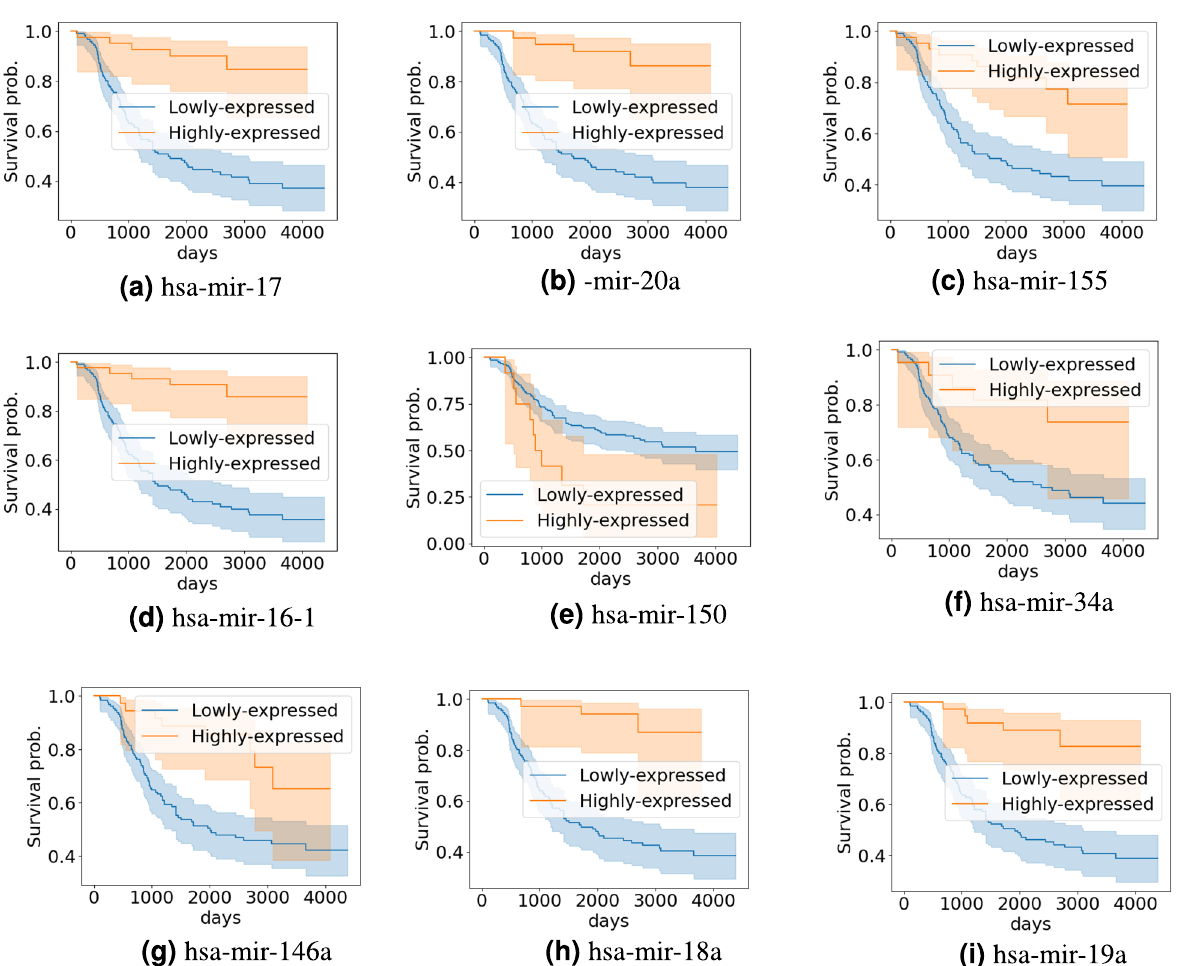
Figure 2. Kaplan–Meyer survival curves of PBLL patients stratified by the top miRNAs with the top highest prediction